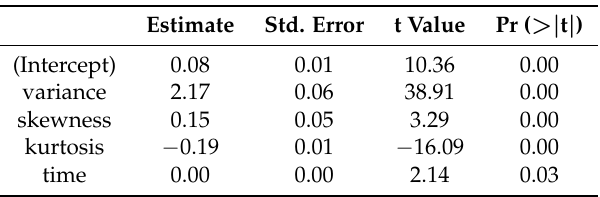
Table 7. OLS results (Step